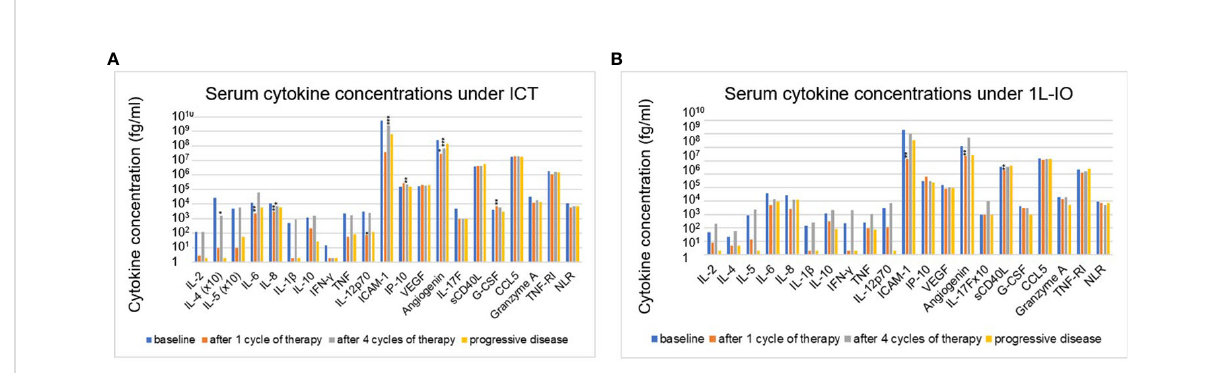
FIGURE 3 Changes of serum cytokines levels under immunotherapy in NSCLC patients compared to baseline values. (A) for patients receiving fi rst-line immunochemotherapy (ICT): baseline (BL), after 1 cycle of treatment (C1), after 4 cycles of treatment (C4), at the time of disease progression (PD). (B) for patients receiving fi rst-line PD-(L)1 monotherapy (1L-IO): baseline (BL), after 1 cycle of treatment (C1), after 4 cycles of treatment (C4), at the time of disease progression (PD). Shown is the mean concentration of each cytokine in the respective patients. An overview of signi fi cant results and the explanation of abbreviations is shown in Table 2; *=p<0.05; **=p<0.01;